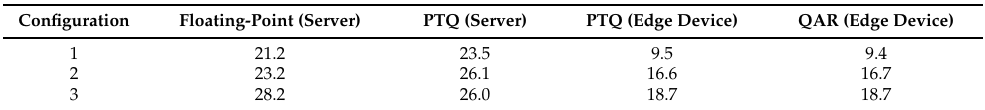
Table 12. Inference time metric benchmark results, given in Hz, for floating-point and quantised models running in different